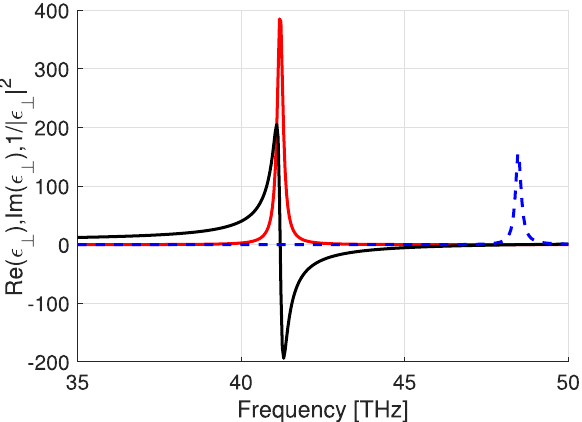
2 ǫ (blue dashed line). | ⊥ |